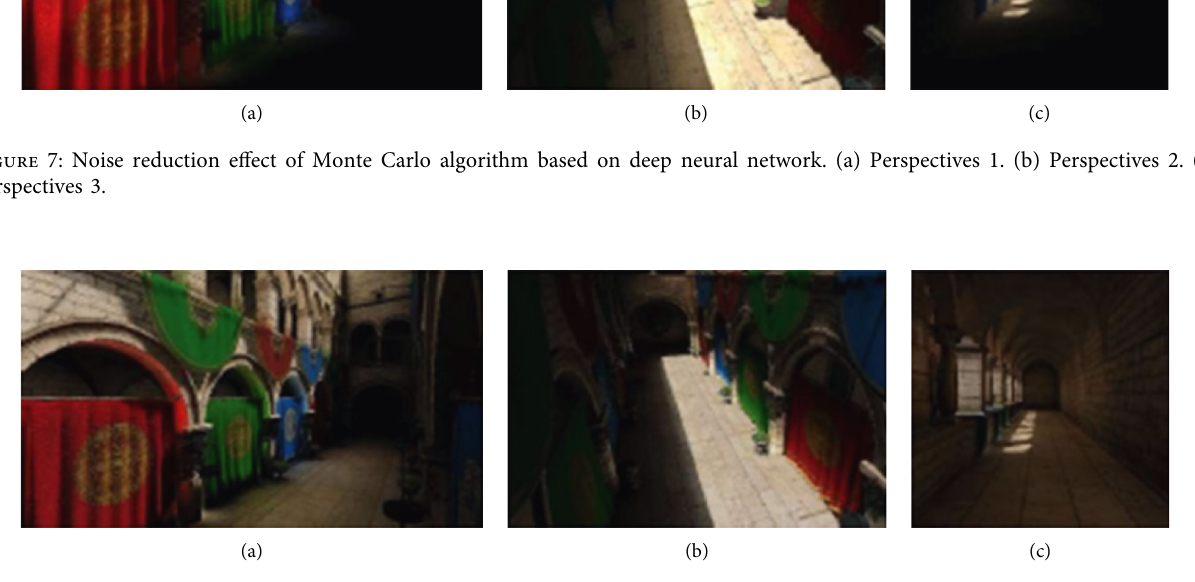
Figure 8: Noise reduction effect of Monte Carlo algorithm based on deep neural network. (a) Perspectives 1. (b) Perspectives 2. (c) Perspectives